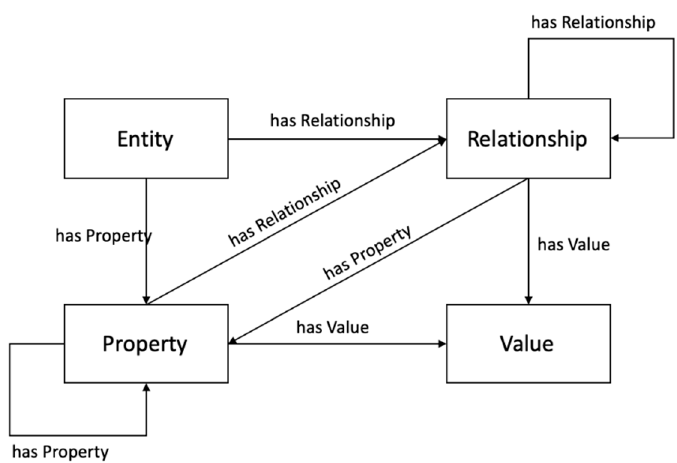
Figure 1. Next Generation Service Interfaces-Linked Data ( NGSI-LD) Information Model.